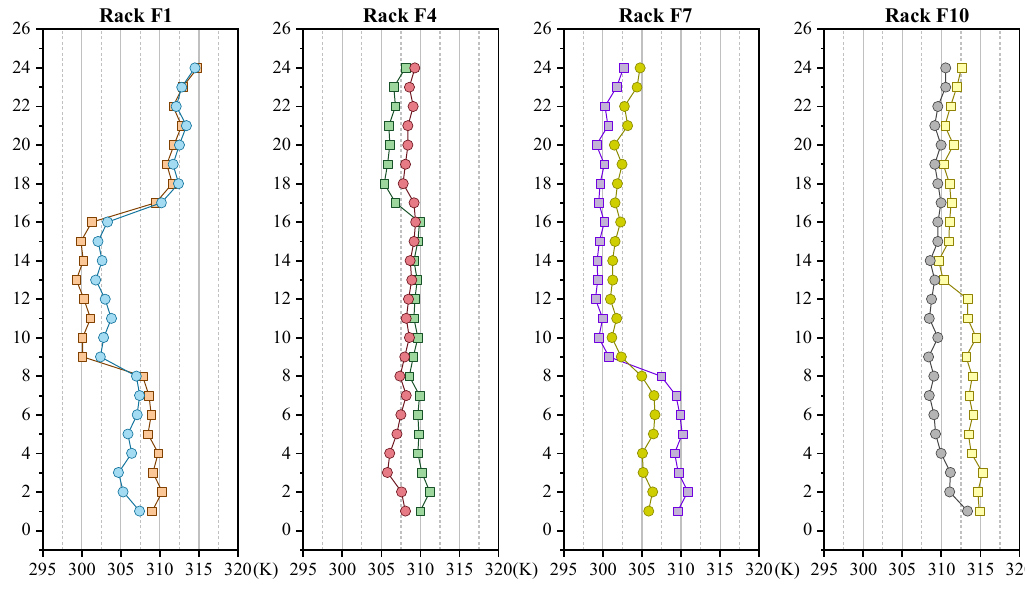
Figure 16. Mean exhaust temperature distribution of racks with/without the terminal device.